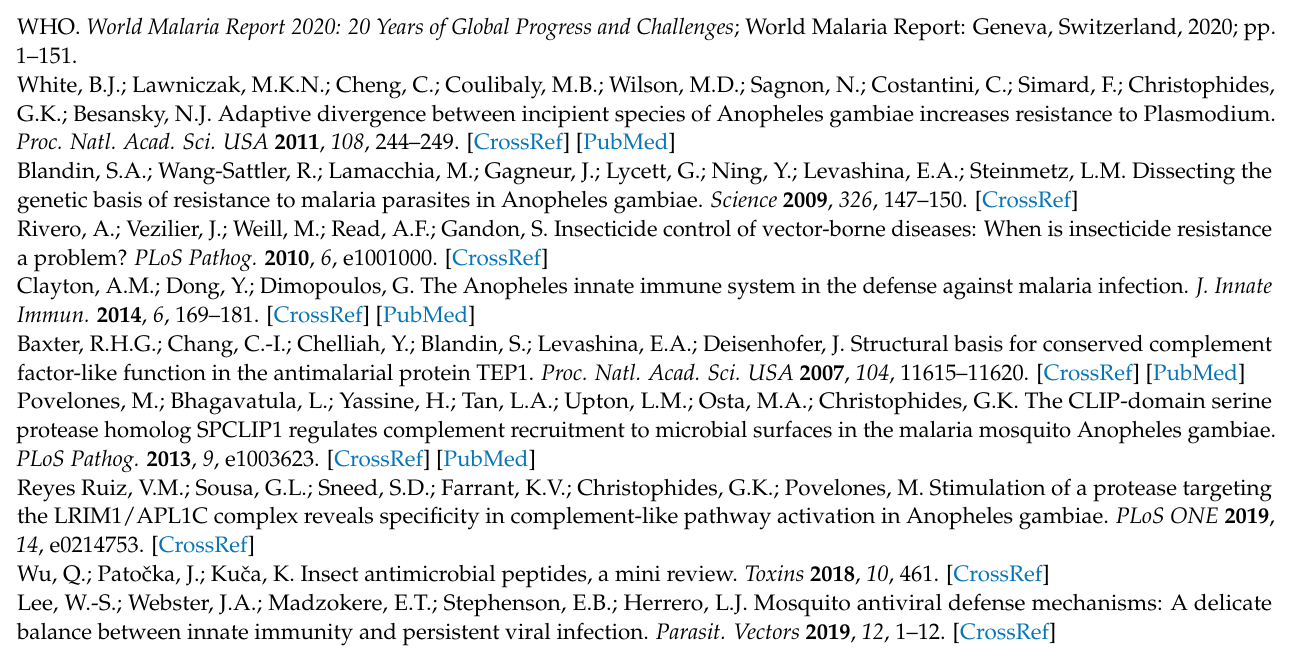
Table S6: π N, π S and numbers of non-synonymous and synonymous sites for other immunity-related genes in An. funestus from PoolSeq data; Table S7: Transcript per million (TPM) counts and means for APL (bolded), LRIM , TEP and AMP genes from RNASeq sampled in Cameroon (CMR), Ghana (GHA), Malawi (MAL), Uganda (UGA), and FANG/FUMOZ laboratory strains. Mean = average of all replicates across experiment. The insecticide treatment and origin of each sample is encoded in replicate names. UNX = unexposed; PER = permethrin; DDT = Dichlorodiphenyltrichloroethane (DDT). Thus, a header containing “MAL.UNX” = a replicate sample in Malawi that was unexposed to insecticide treatment; Table S8: DESeq2 differential gene expression results between countries and laboratory strains for APL (bolded), LRIM , TEP and AMP genes. Analysis was run using iDEP. Log 2 -fold change and adjusted p -value are given for every pairwise contrast made, for example “FANG-Cameroon log2FoldChange” refers to the FANG versus Cameroon contrast Log 2 -fold change. Only genes with greater than 0.5 counts per million in four or more replicates passed pre-filtering in iDEP; File S1: Log file of GARD predicted breakpoints in the codon-aligned multiple sequence alignment of the five An. funestus APL1